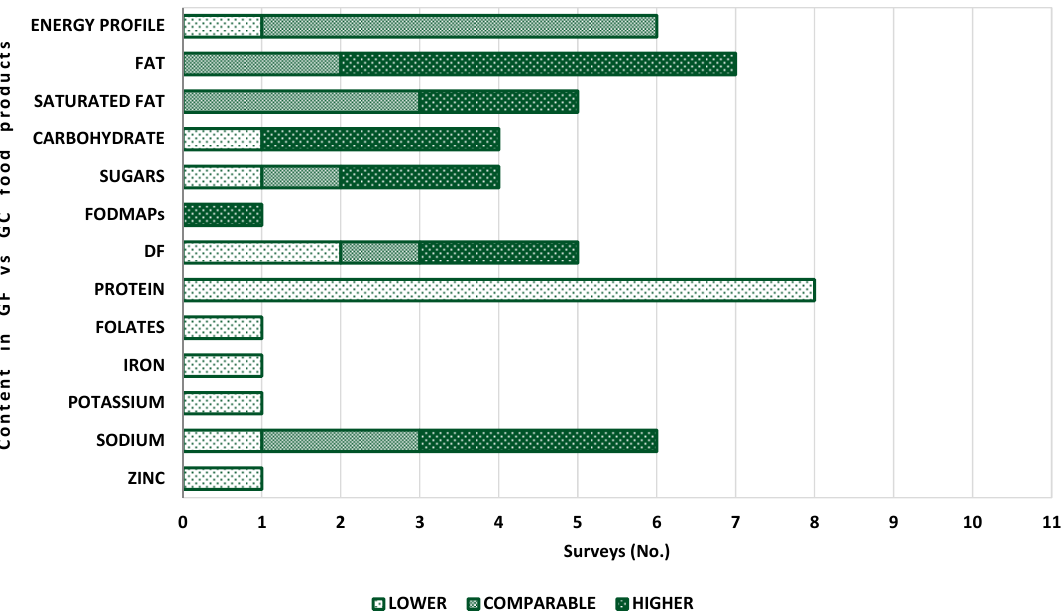
Figure 3. Comparison between GF food products and GC equivalents in terms of energy and nutrient content, as emerged from surveys.